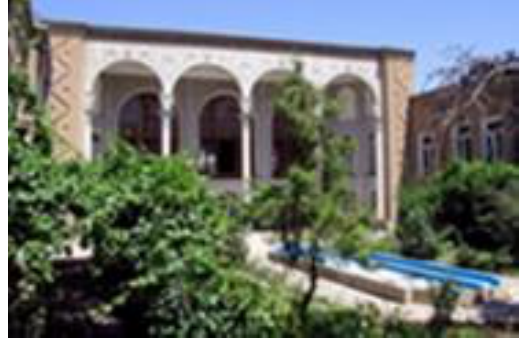
Figure 3 Courtyard house No.2 (Source: Iran Cultural Heritage, Handicrafts and Tourism